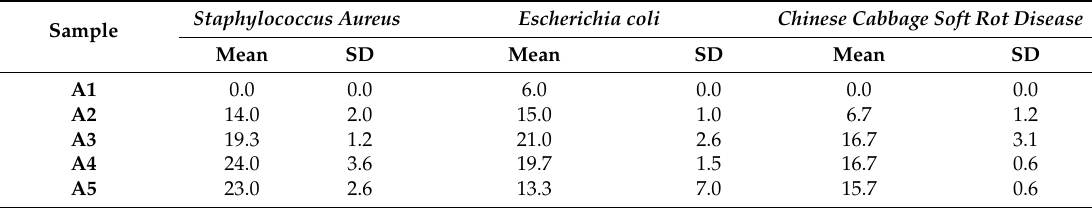
Table 4. The inhibitory zone diameter s (mm) of the ILs in the A and B